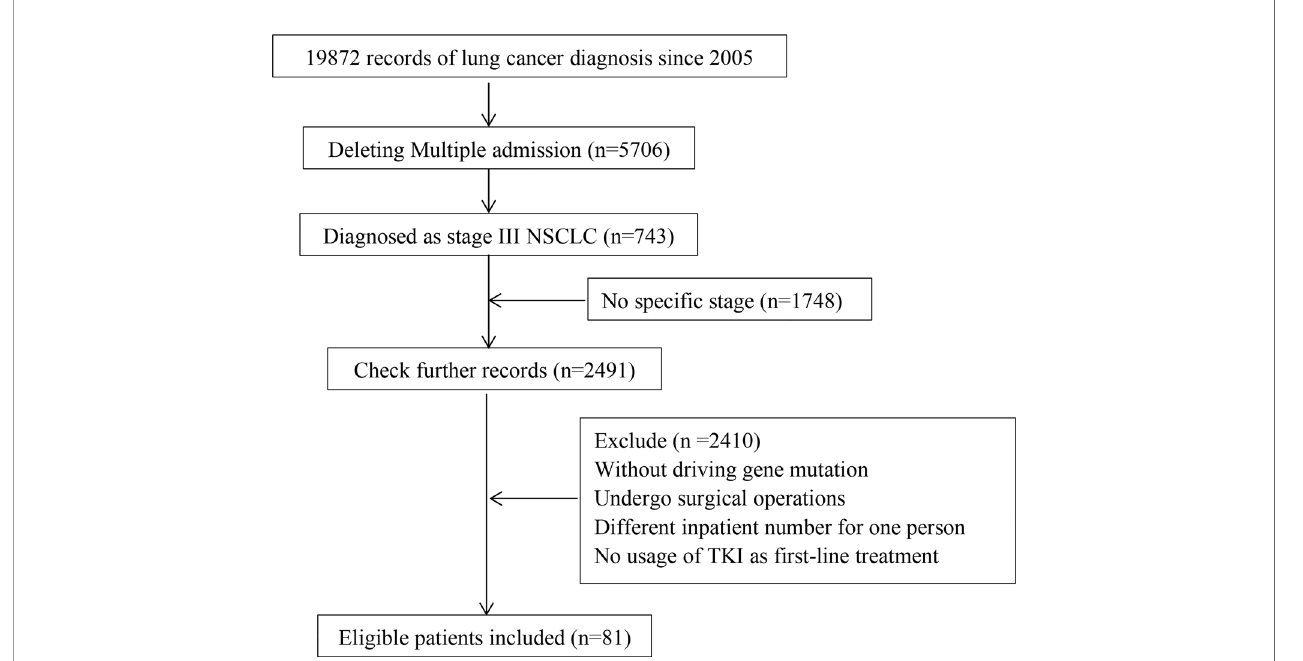
FIGURE 1 | The fl owchart of this study. Including collection, screening, follow-up of in volved patients.